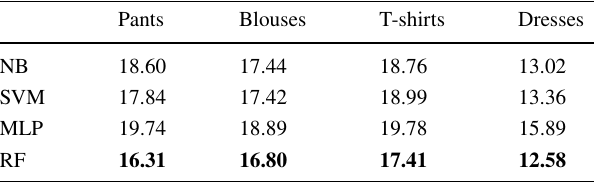
Lowest errors are shown